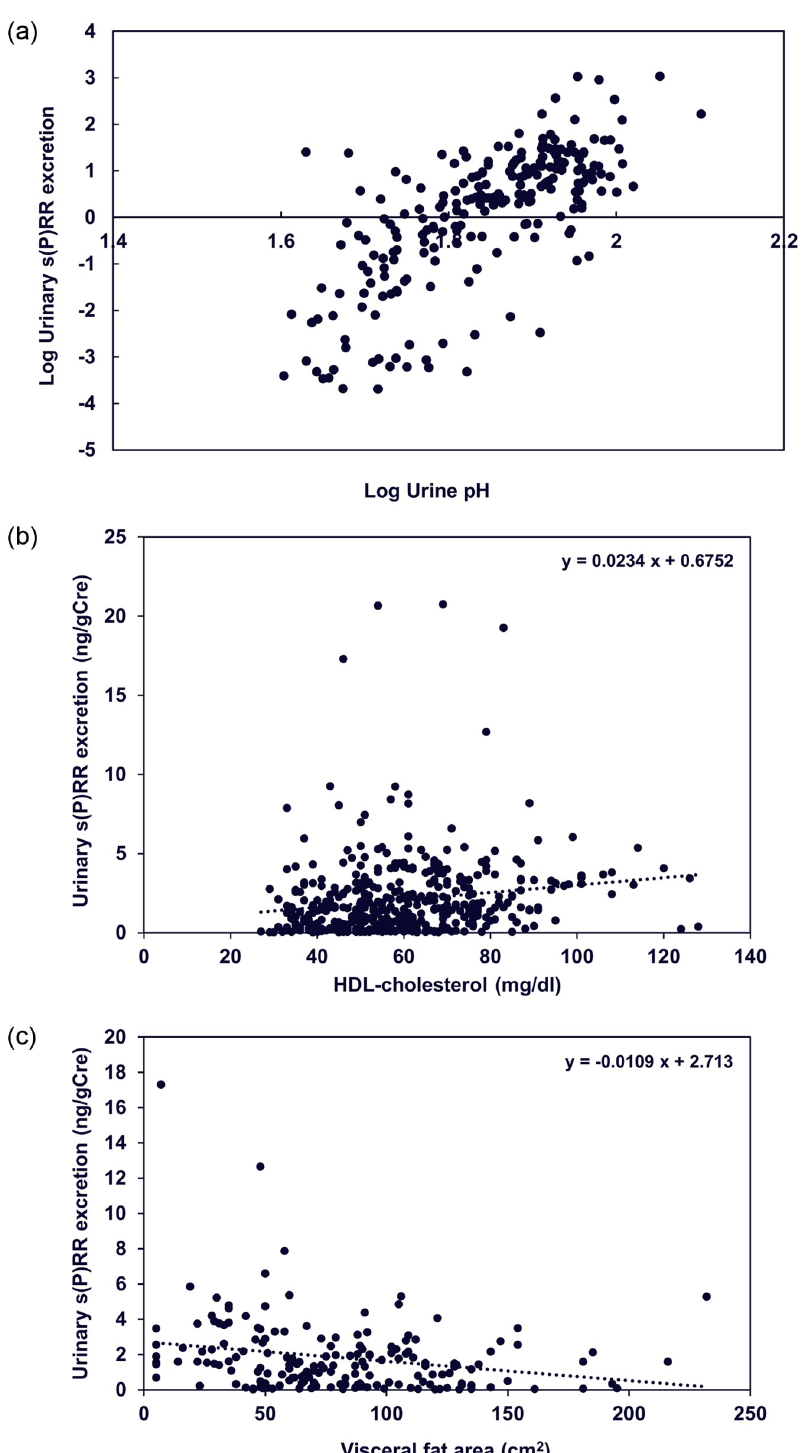
Fig 3. Scattergrams showing relationship between log urine pH (a) and log urinary s(P)RR excretion (a) and HDL-cholesterol (b) or visceral fat area (c) and urinary s(P)RR excretion. s(P)RR, soluble (pro)renin receptor; HDL, high-density